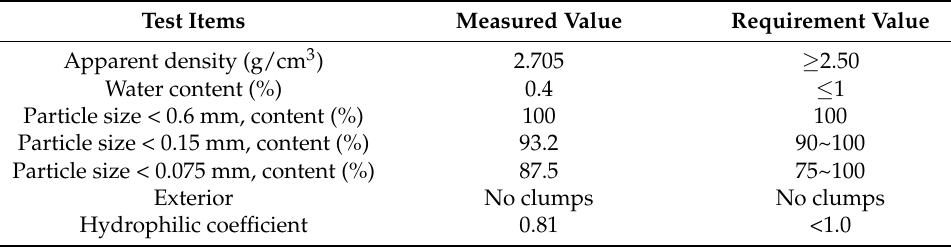
Table 3. Basic technical indicators of